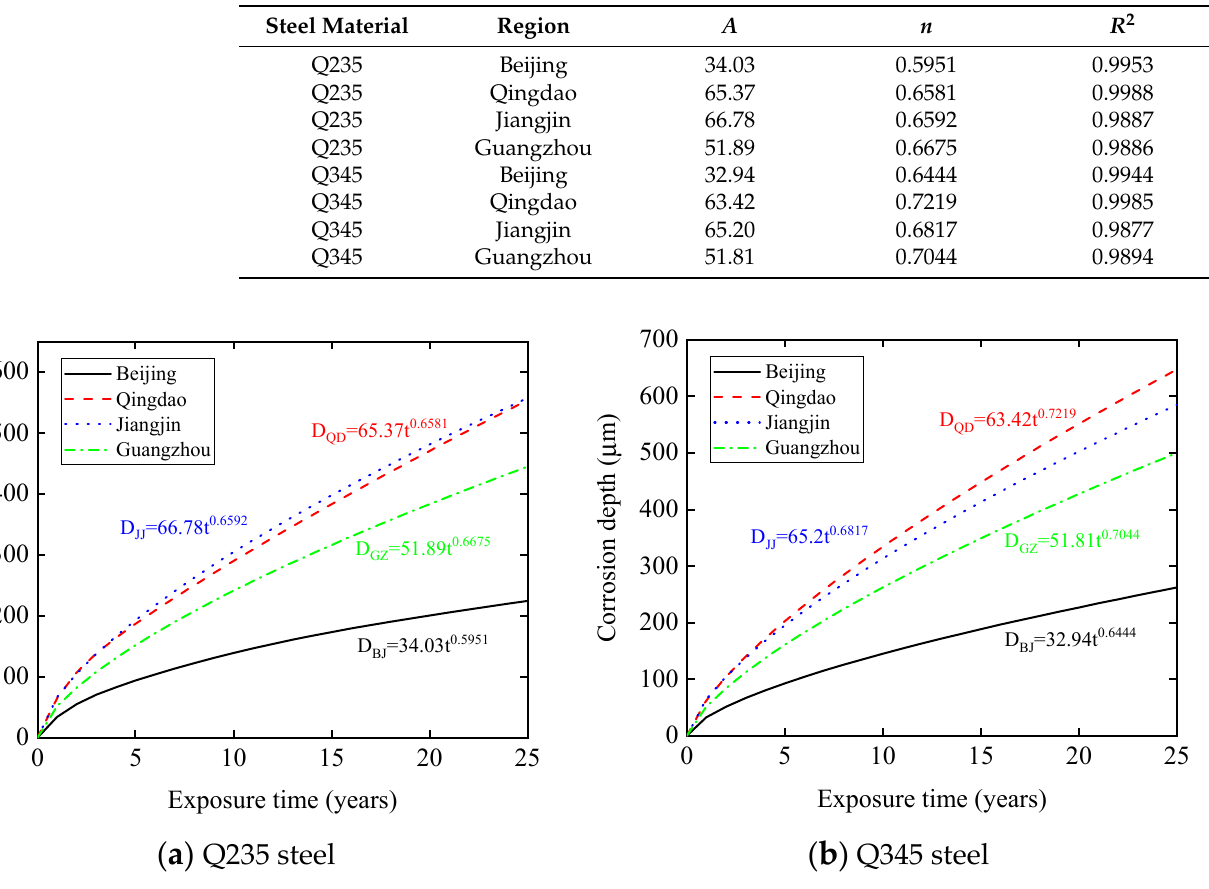
Figure 18. Fitting curves of corrosion depth.